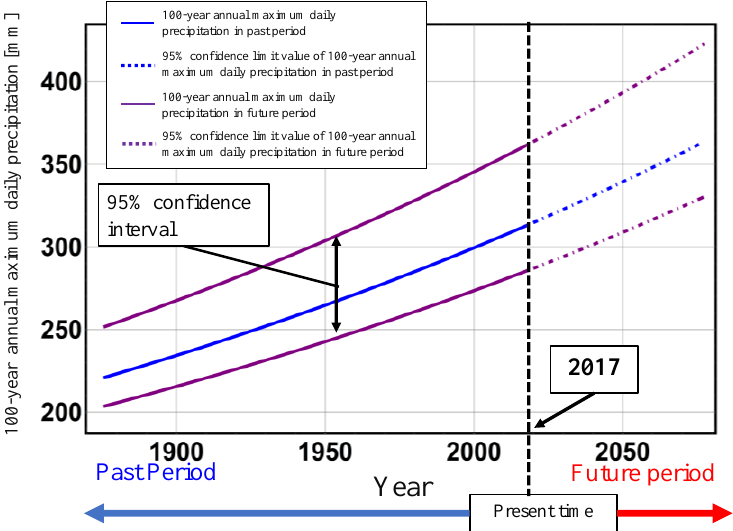
Figure 10. Temporal change of 100-year annual maximum daily precipitation and its 95% confidence interval.